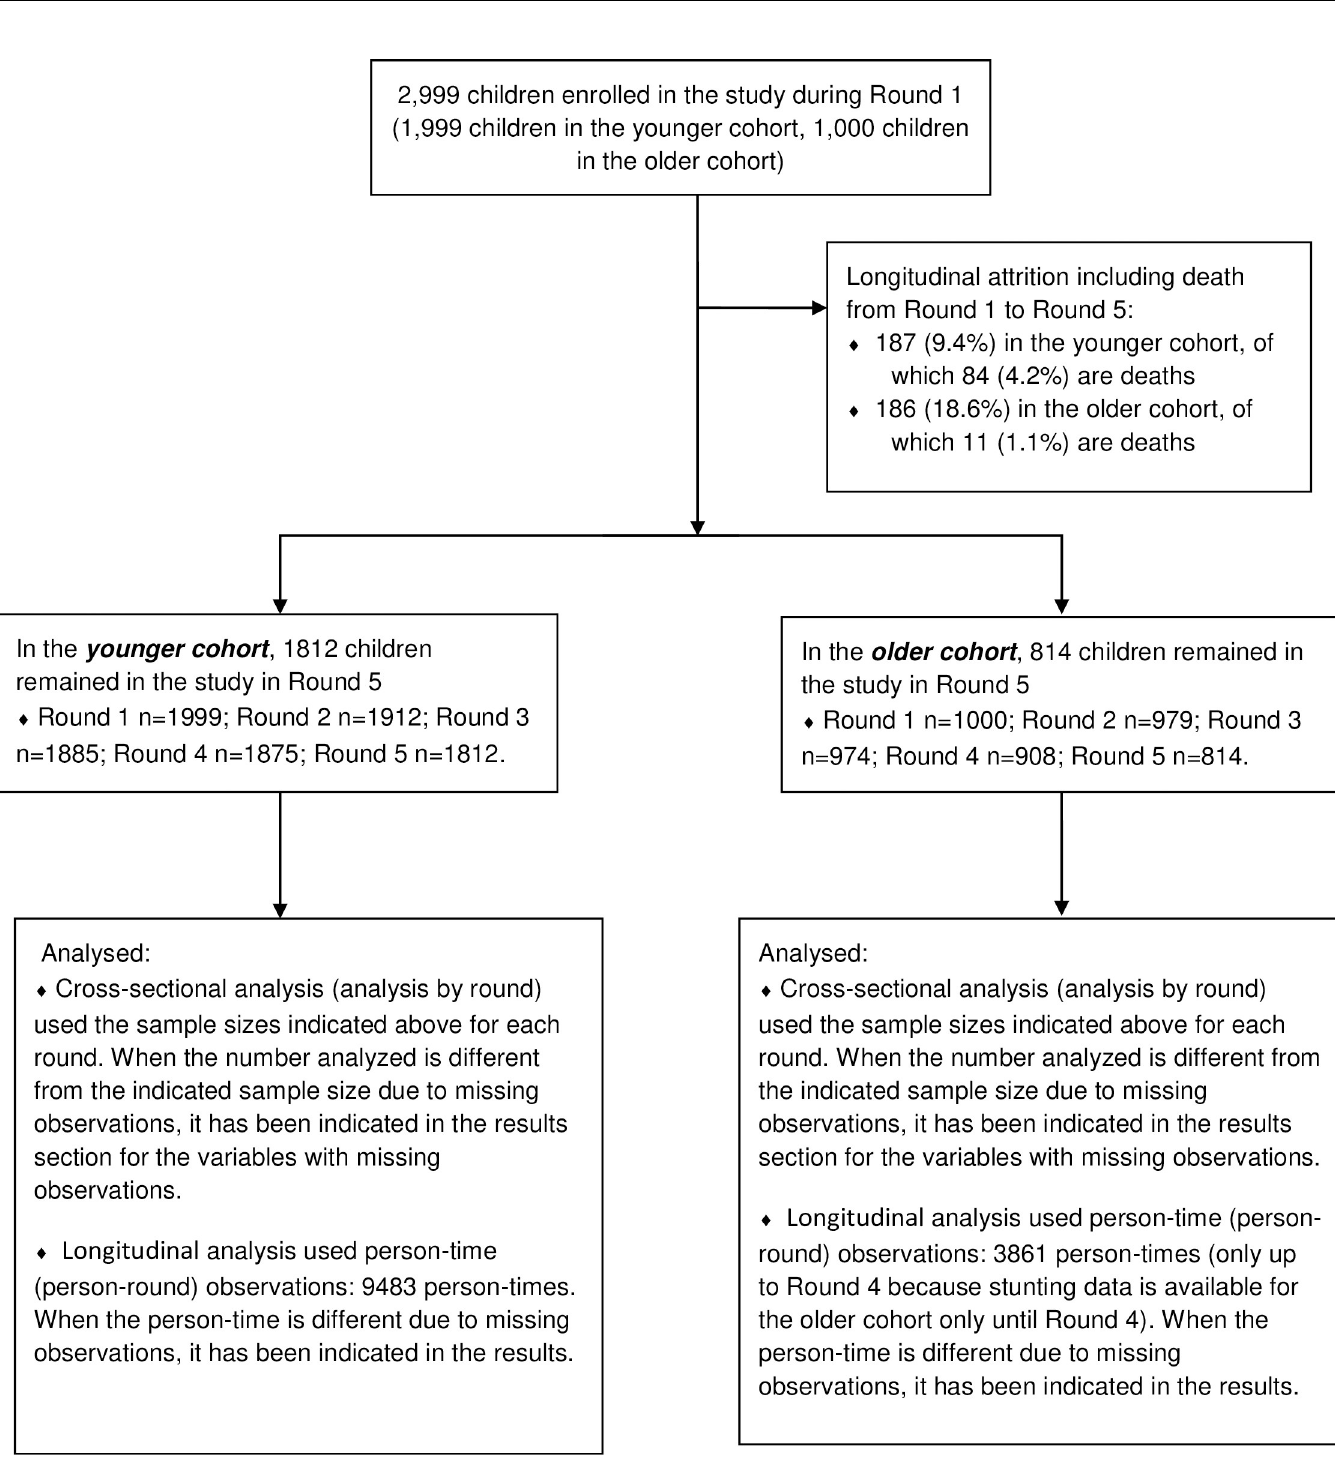
PLOS ONE | https://doi.org/10.1371/journal.pone.0229011 February 7,